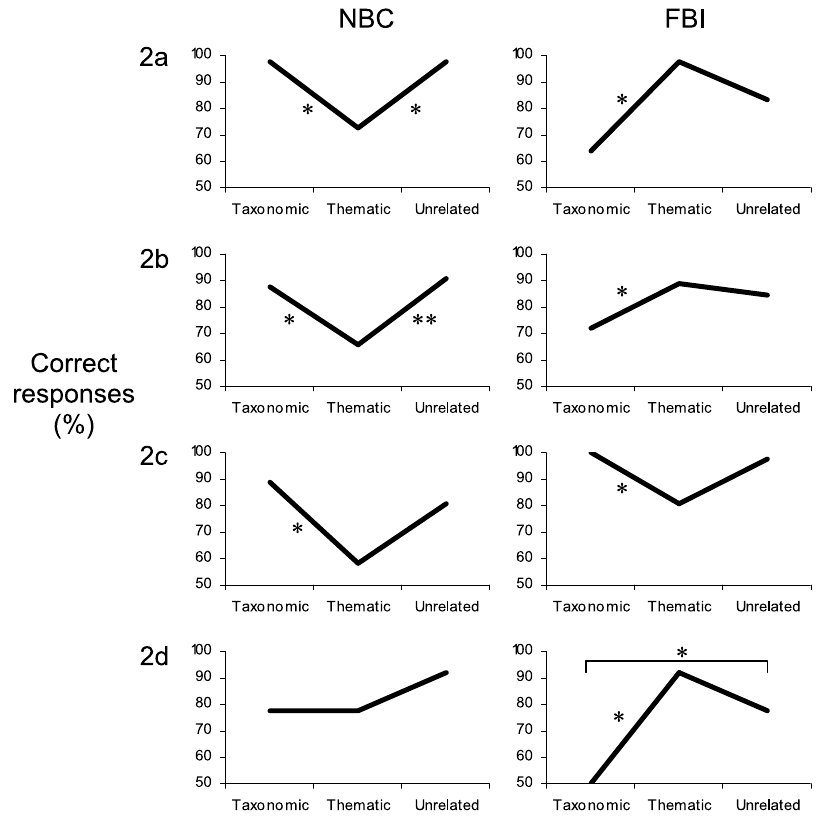
Fig. 1. The percentage correct responses in Experiment